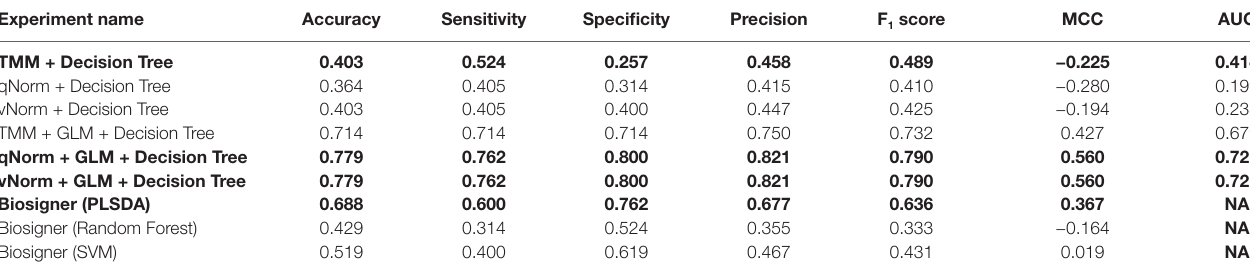
The best model with corresponding performance measures in each subgroup of experiment is presented in bold